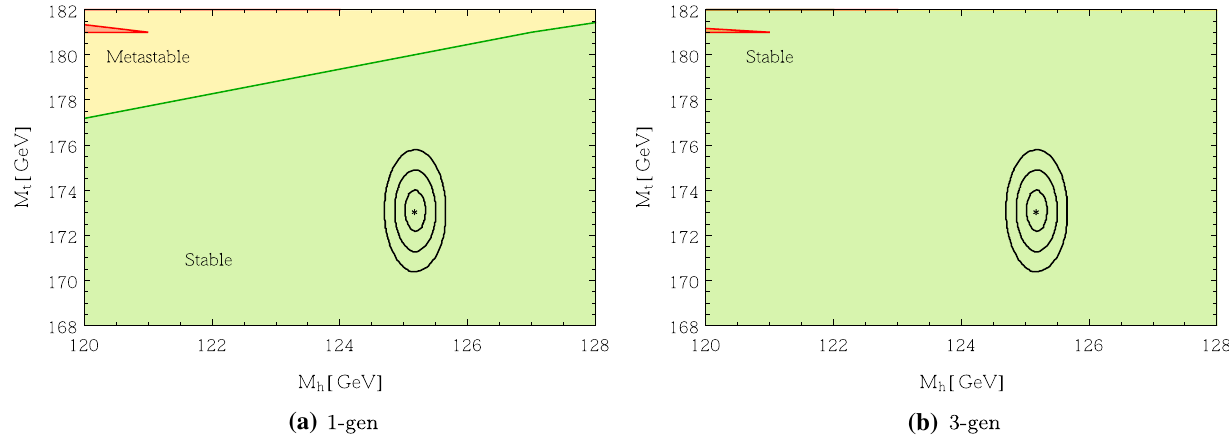
Fig. 14 Phase diagram for S 3 with M h in GeV vs M t in GeV. The stable, metastable and unstable regions are delineated by green, yellow and red colours, respectively. The black dot denotes the current values of Higgs mass and top mass in GeV, and black circles are 1 σ , 2 σ and 3 σ